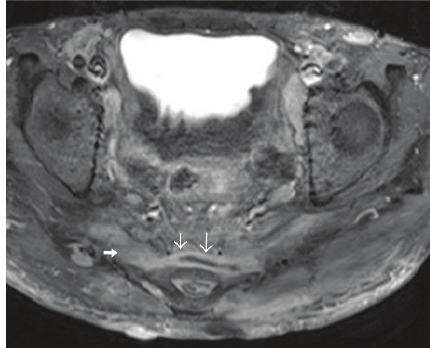
Figure 5: Axial T1-weighted fat-suppressed image postcontrast shows a well-defined rim-enhancing collection (white arrows) at the anterior perisacral space compatible with abscess, as well as abnormal marrow enhancement (thick arrow) in the sacrum consistent with osteomyelitis.